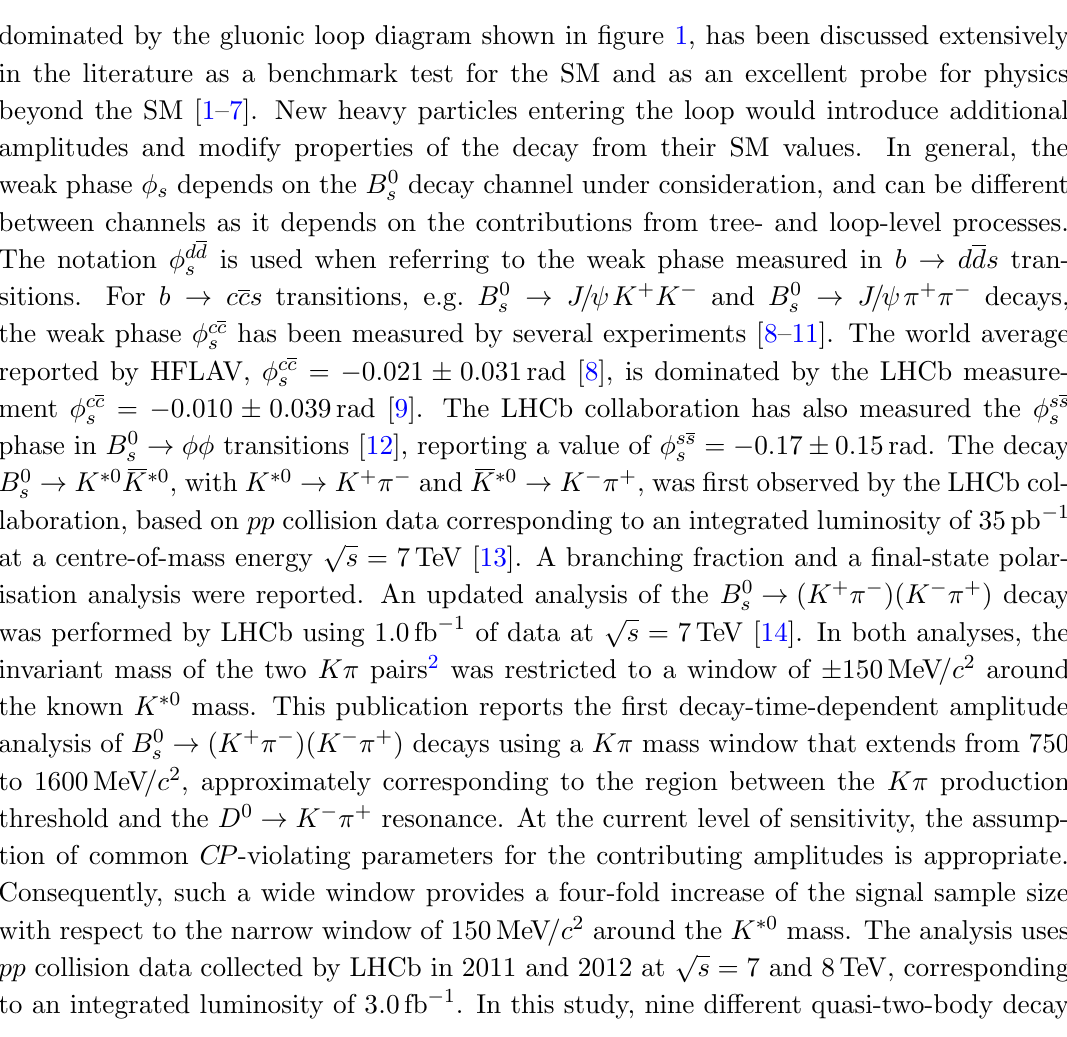
K (cid:3) 0 K (cid:3) 0 s !